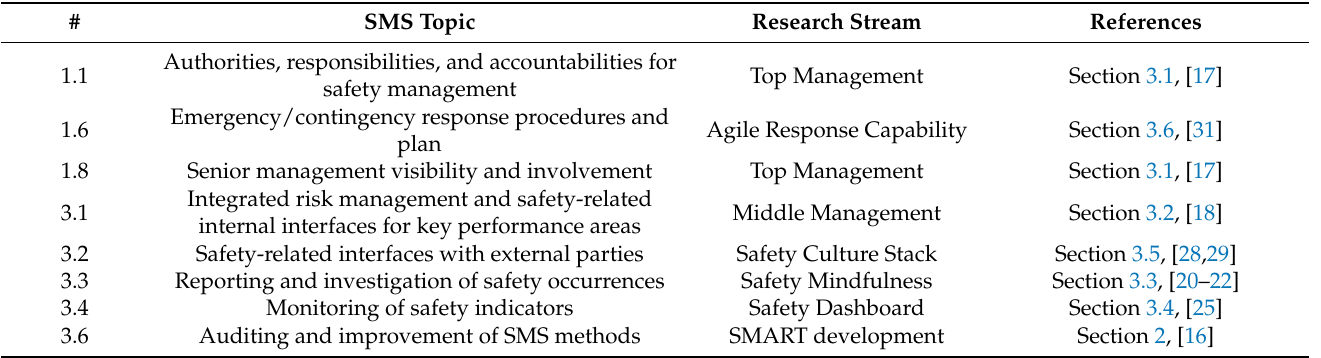
Figure 4. Graphical view of the impact of advanced safety management approaches along the SMART topics. Darker colours depict larger impact. Table 2. SMS topics that are addressed most effectively by the research streams for advancing safety in organisations.